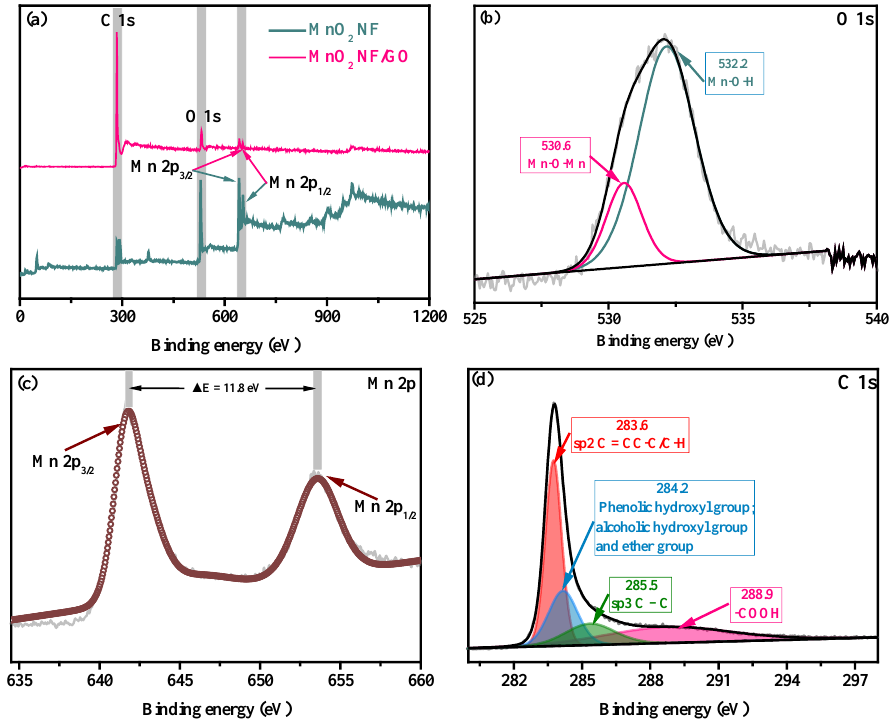
Figure 3. XPS survey spectra of MnO 2 NF and MnO 2 NF/GO composites ( a ); O 1s ( b ); Mn 2p ( c ); and C 1s ( d ) spectra of MnO 2 NF/GO composites.